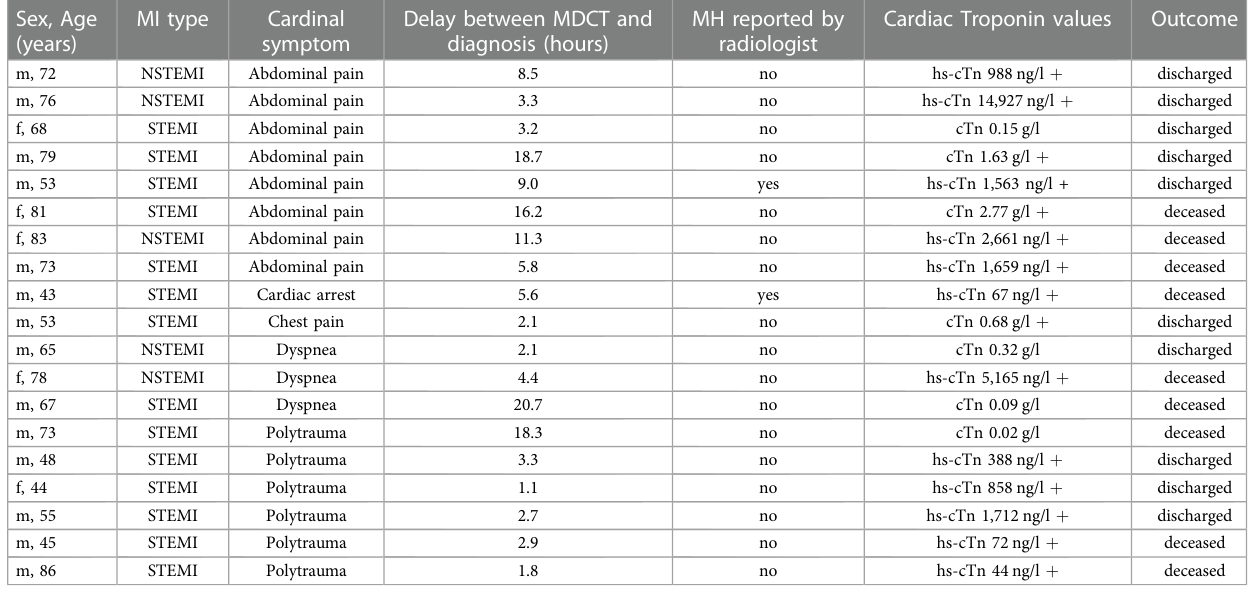
TABLE 1 Sex, age, cardinal symptoms, MI type, delay between MDCT and diagnosis, radiologist reports, cardiac Troponin T values and clinical outcome of patients with